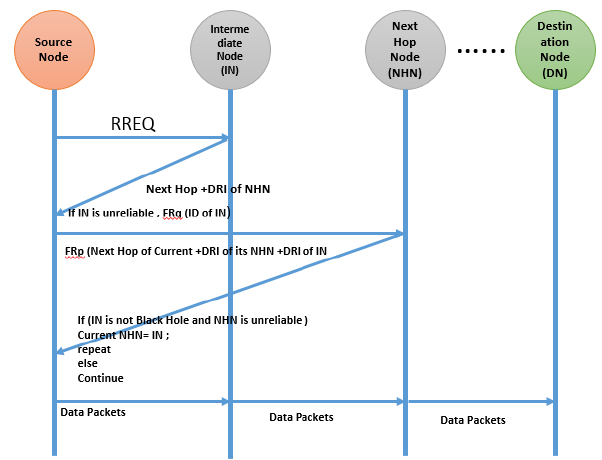
Fig. 10 Cross checking for Black hole nodes